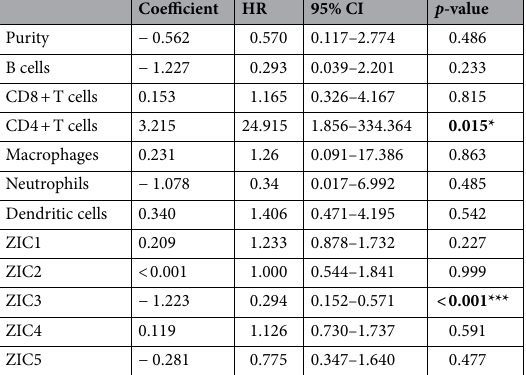
Table 4. Cox proportional hazards model factors related to survival, immune infiltrates and genes in GBM patients. HR hazard ration, 95% CI 95% confidential interval. * p < 0.05, ** p < 0.01, *** p < 0.001. Bold values indicate clinical significance.